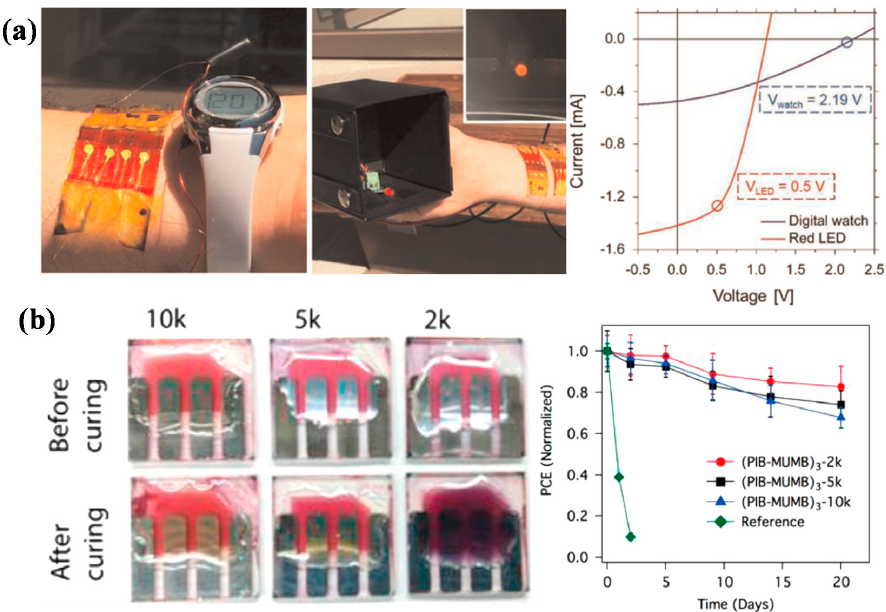
Figure 14. ( a ) Wearable organic solar cells on skin powering: a wearable digital watch in outdoor sunlight and an LED in outdoor sunlight (980 W·m − 2 ), corresponding I–V characteristics of P3HpT:PCBM solar cells powering an LED(red) and digital watch(blue). Reprinted from [143], Copyright 2016, with permission from Elsevier. ( b ) Encapsulated device before and after photo-crosslinking and device stability in air. Reprinted from [140], Copyright 2016, with permission from Elsevier.